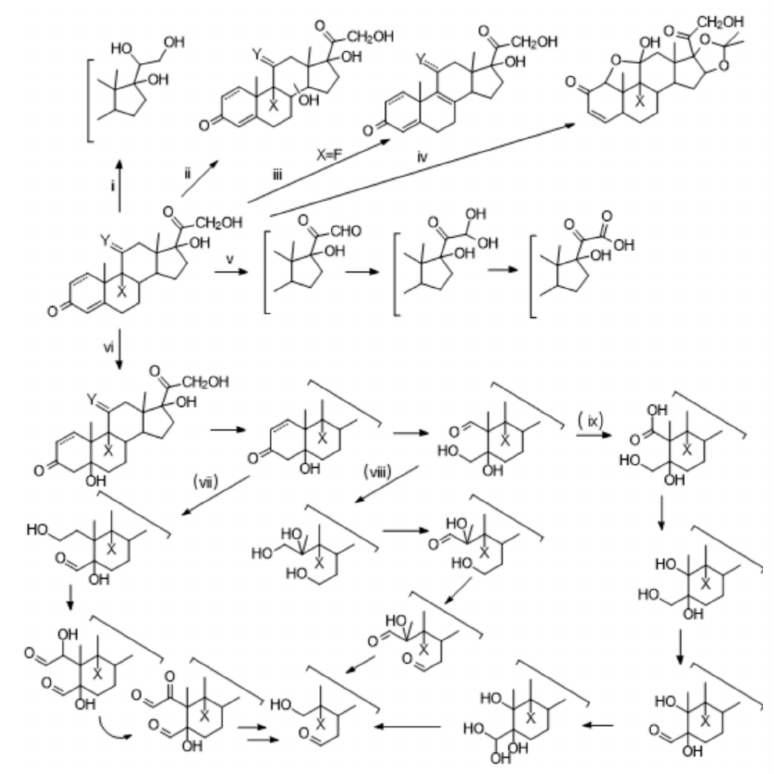
Scheme 4. Paths followed in the photocatalytic degradation of